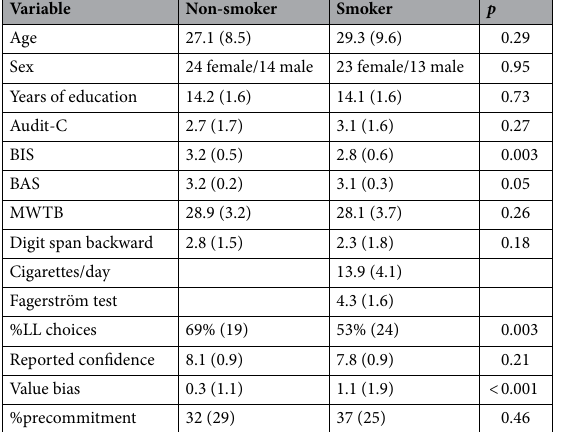
Table 1. Demographic characteristics of the non-smoker and smoker groups. We report group-specific means, standard deviations are in brackets. We also report the percentage of larger-later (LL) choices and mean confidence ratings in the confidence accuracy task, the mean value bias (self-reported minus revealed LL reward values) in the bidding task, and the percentage of precommitment choices in the precommitment